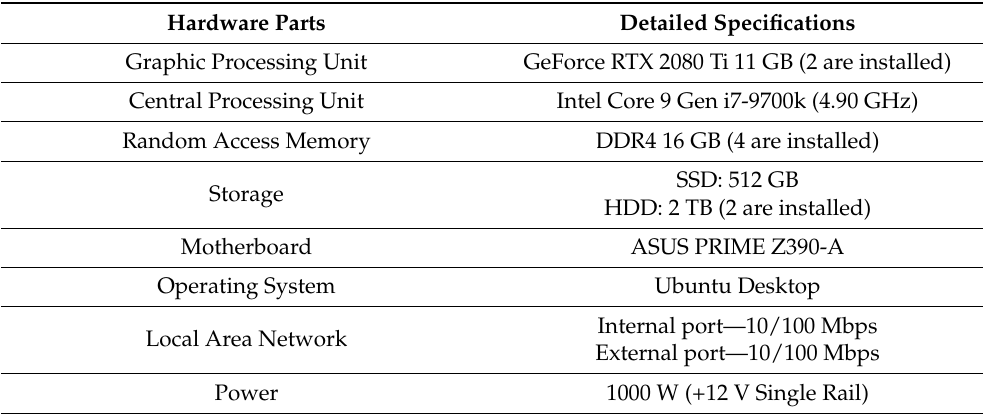
Table 6. The detailed specifications of the AI server.